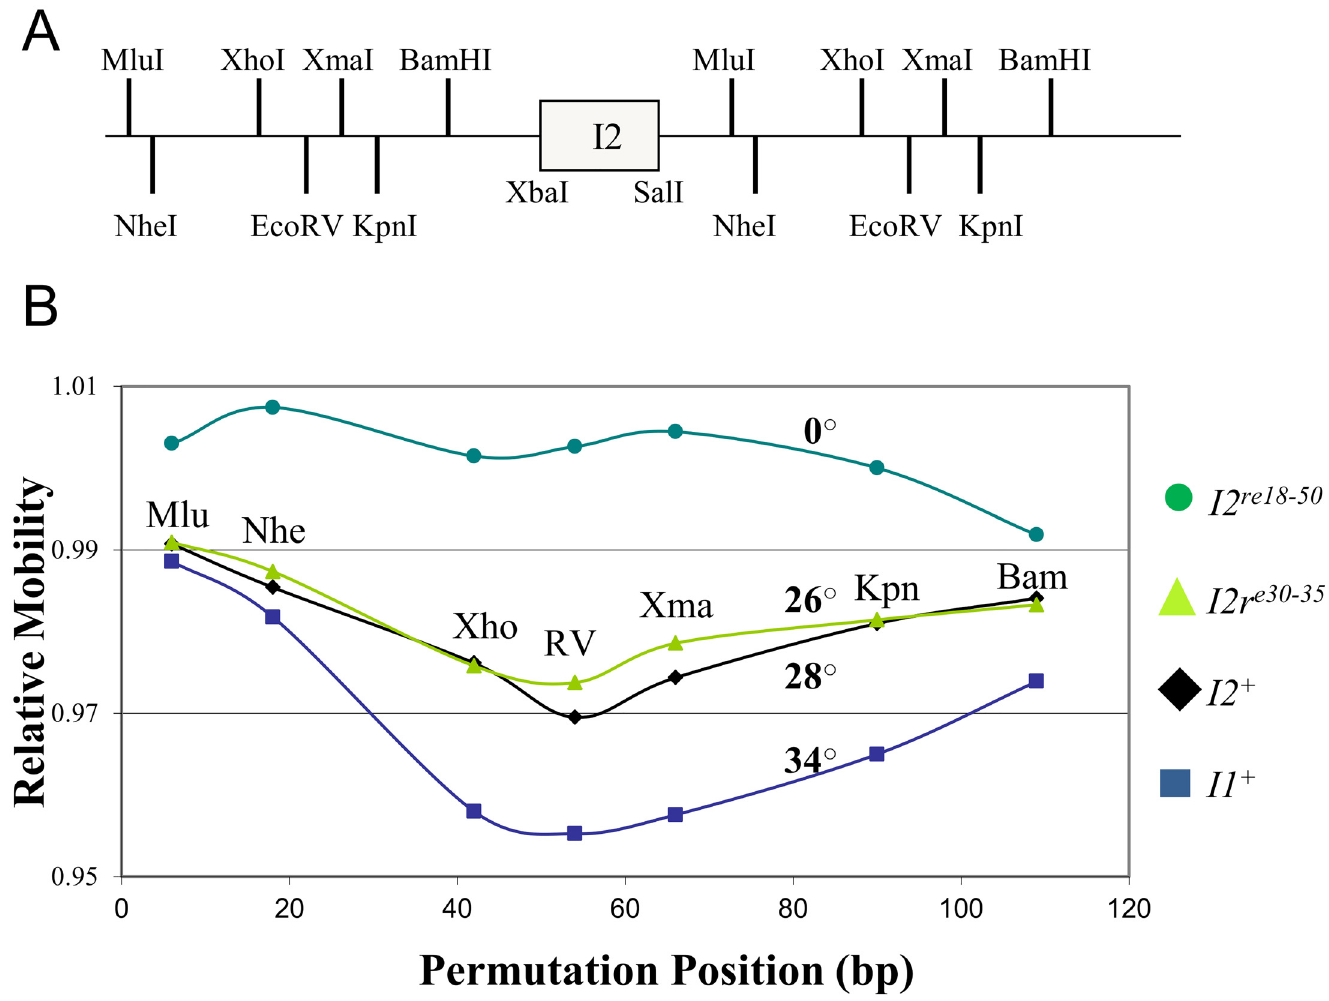
Fig 3. A static bend at I2 : permutation analysis of a 150 bp DNA fragment containing λ I1 + , I2 + , I2 re30-35 , or I2 re18-50 . A. Diagram of the pBend plasmid showing the XbaI and SalI sites used to insert the I2 segments. Flanking the I2 inserts are repeated segments with the restriction enzyme target sites used to generate DNAs with permutations of I2 position. B. Relative mobilities of the permuted DNA fragments versus positions of the I2 segment. Relative mobility 1.0 indicates the mobility of a 150 bp DNA marker. The calculated bend angles [40] are given adjacent to the relevant mobility curve.